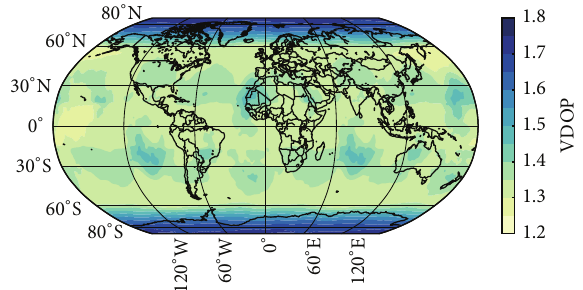
Figure 2: Global simulation of average VDOP using GPS only ( 5 ∘